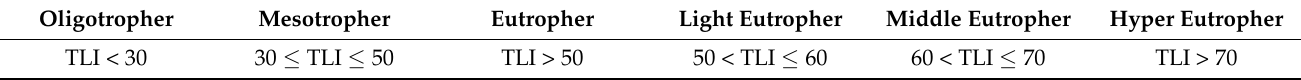
Table 3. Classification of nutritional status of lakes